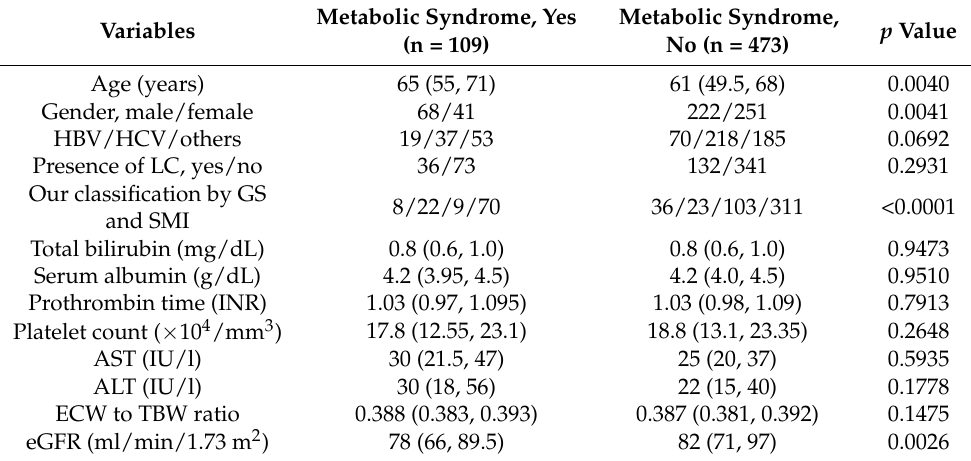
Figure 6. ( A ) Proportion of Met-S in patients with sarcopenia and non-sarcopenia in patients with BMI ≥ 25 kg/m 2 (n = 188). ( B ) Proportion of Met-S in patients with sarcopenia, dynapenia, presarcopenia, and control in patients with BMI ≥ 25 kg/m 2 . ( C ) Proportion of Met-S in patients with sarcopenia and non-sarcopenia in patients with BMI < 25 kg/m 2 (n = 394). ( D ) Proportion of Met-S in patients with sarcopenia, dynapenia, presarcopenia, and control in patients with BMI < 25 kg/m 2 . Table 2. Univariate analyses of factors linked to the presence of metabolic